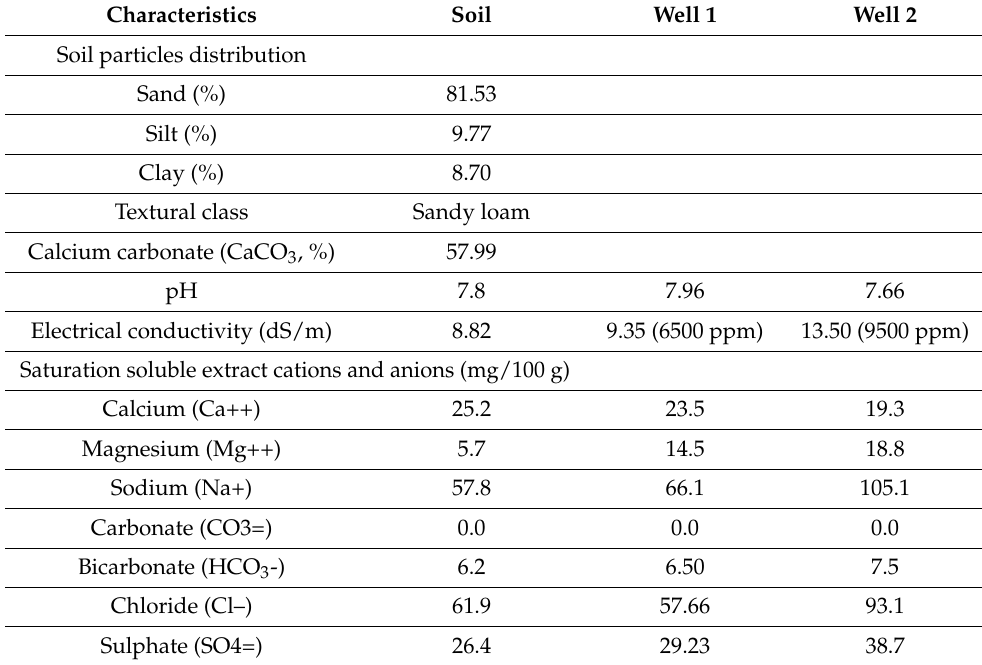
Table 2. Physical and chemical properties of soil and irrigated water.